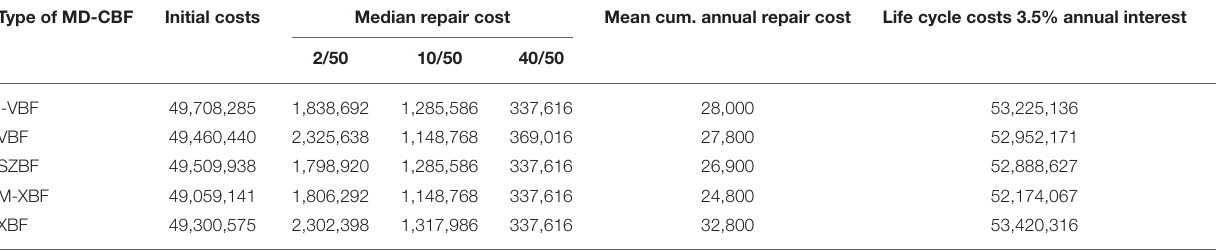
TABLE 8 | Summary of the initial, median repair, and life cycle costs